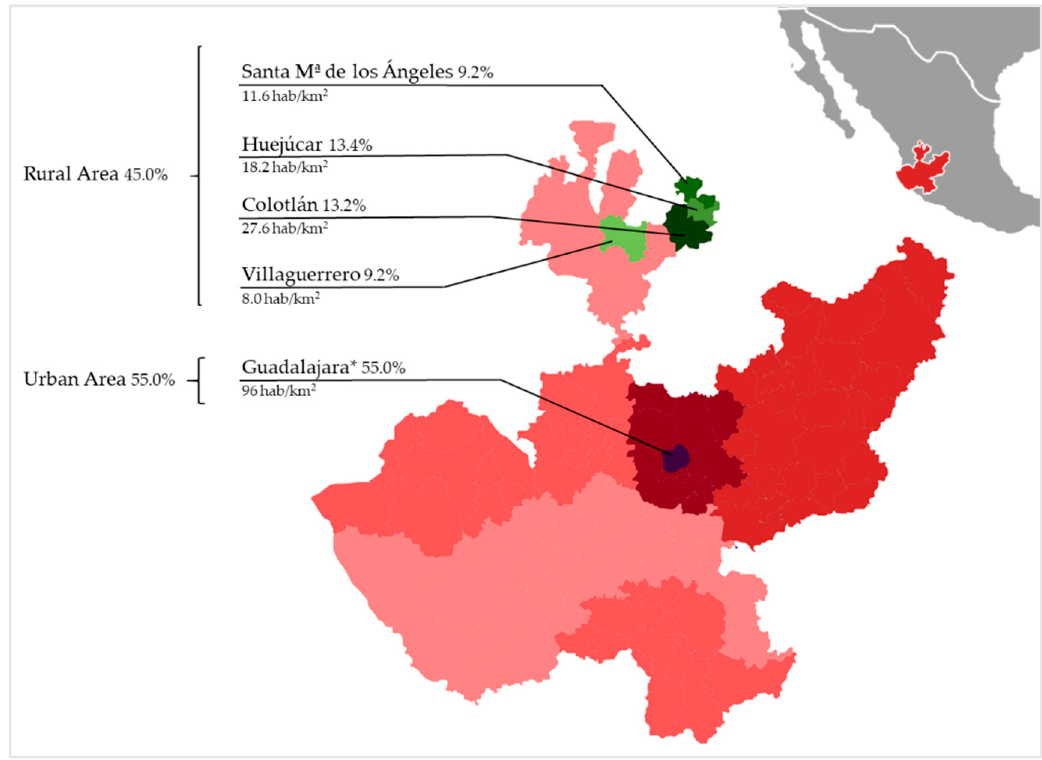
Figure 1. Percentage of adolescents evaluated and population density by area. * Metropolitan Area; green color= Rural Area; purple color= Urban Area.